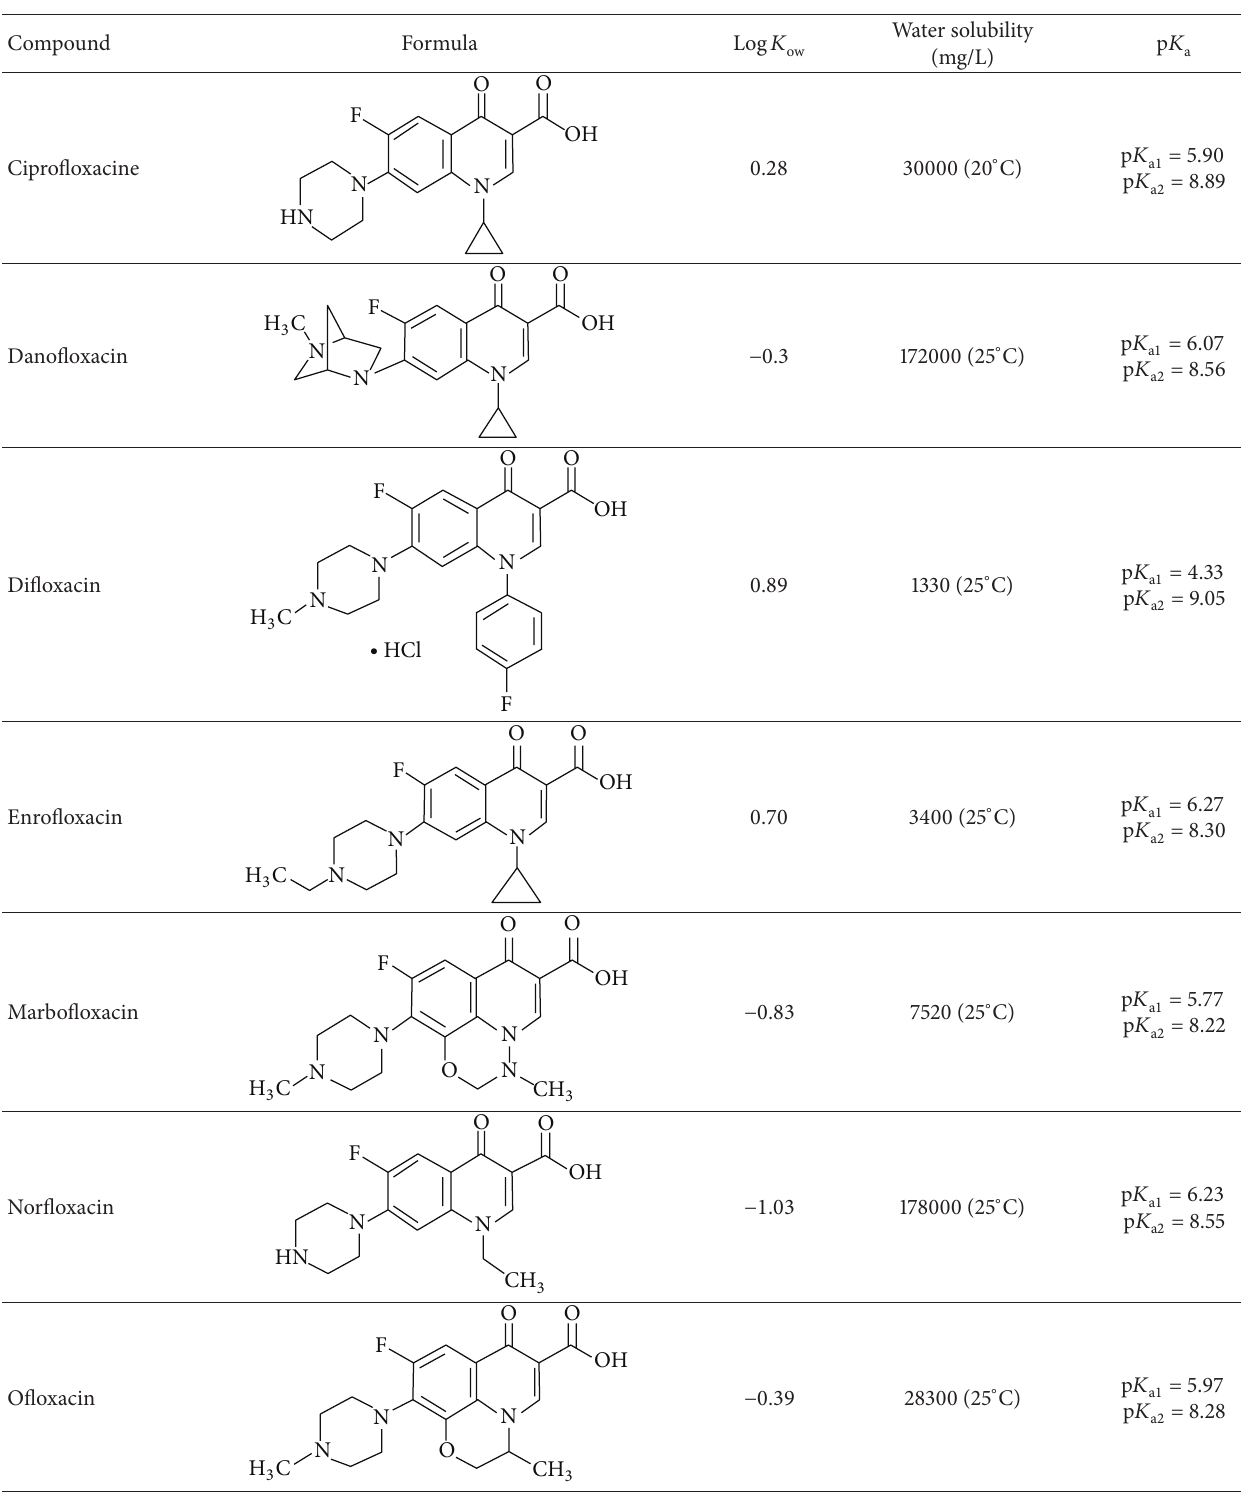
Table 1: Physicochemical properties of selected